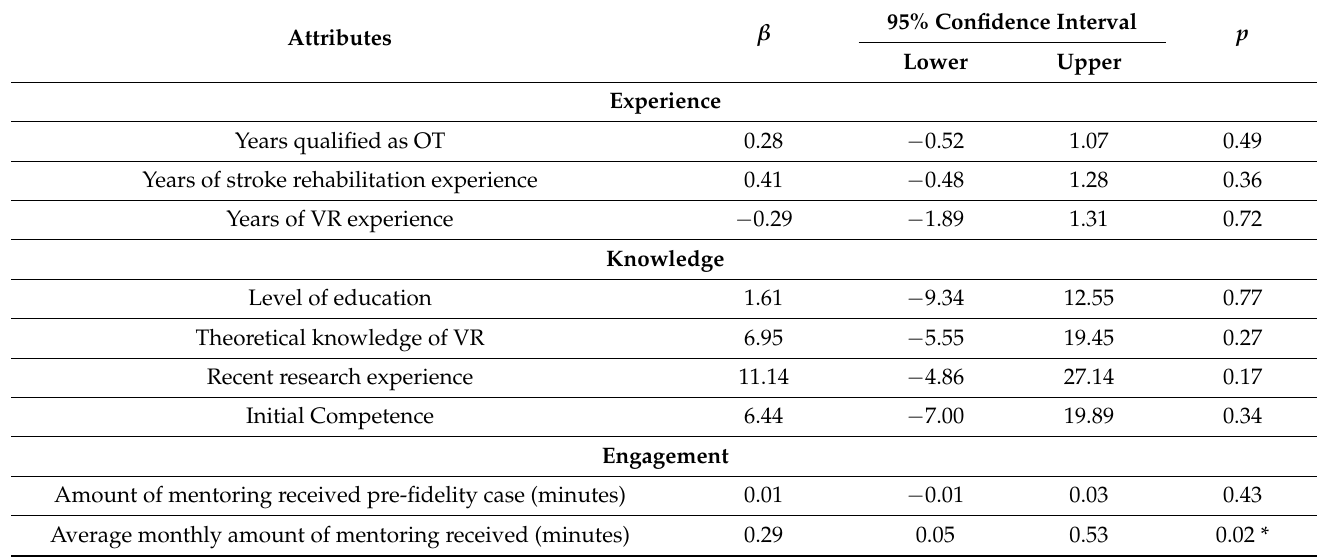
Table 3. Relationship between OT attributes and fidelity assessment score for 39